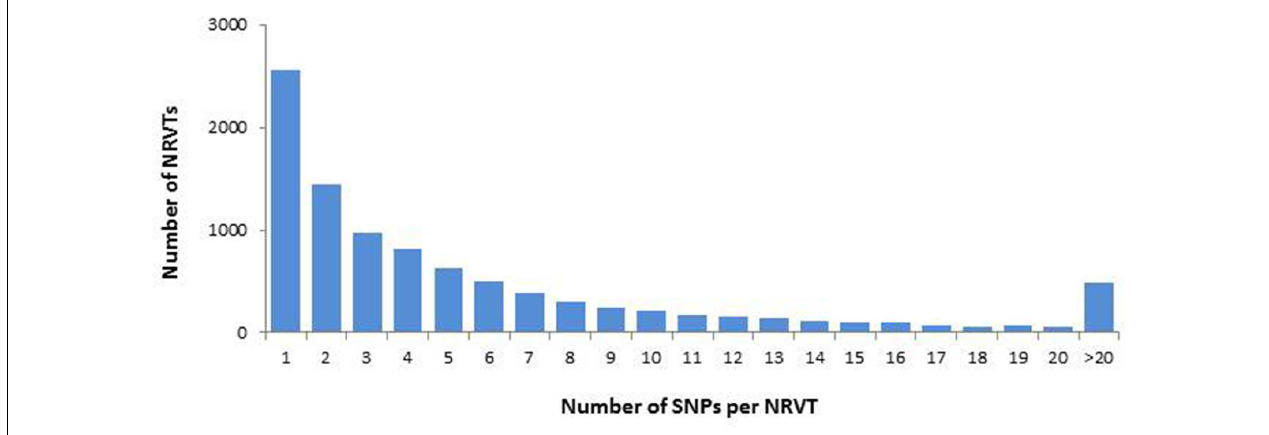
FIGURE 1 | Single nucleotide polymorphism (SNP) distribution in GiroV1 assembly. SNPs were identified by the quality-based variant detection procedure in CLC software and the number of NRVTs containing various densities of SNPs were calculated in